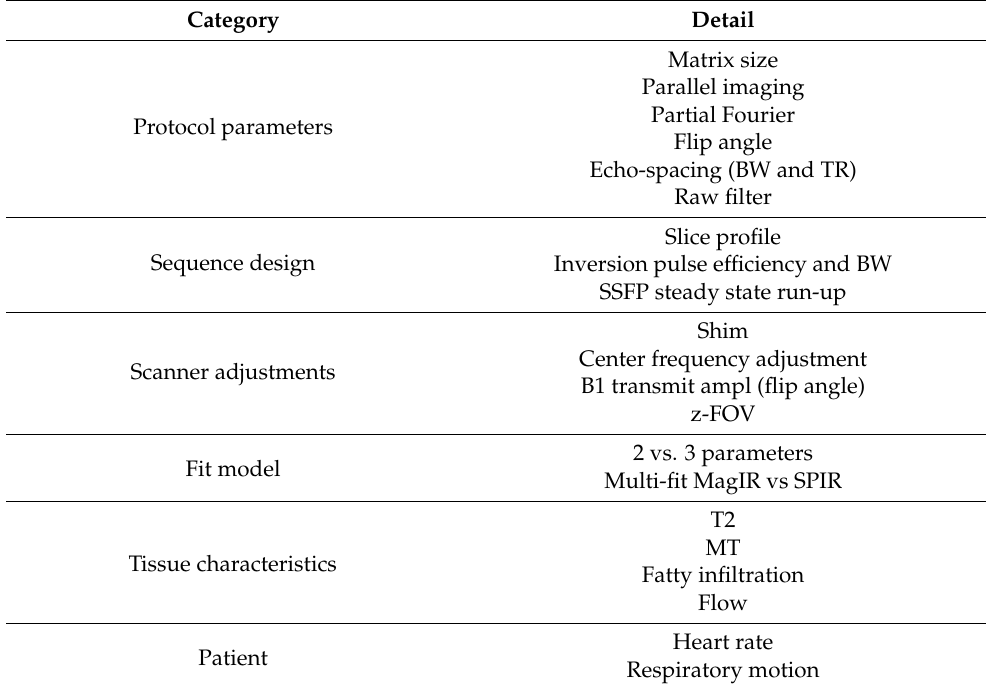
Table 2. MRI Measurement Uncertainty Elements in Medical Imaging [19].